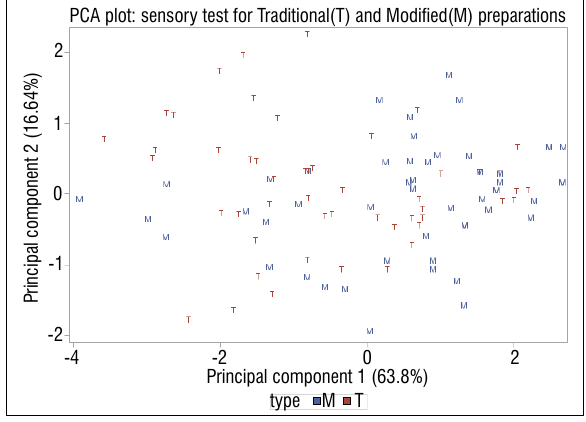
Principal component analysis (PCA) of the sensory evaluation of traditional (T) and modified (M) motoho by 51 panellists who rated the appearance, aroma, mouth feel and flavour of motoho using a nine-point hedonic